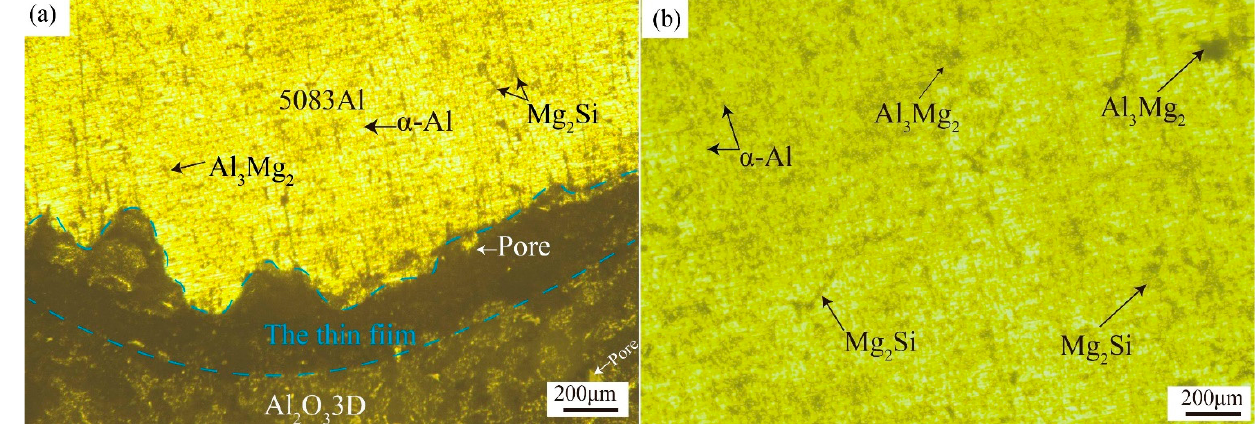
Figure 3. Optical micrograph (OM) image of two materials: ( a ) Al 2 O 3 3D/5083 Al; ( b ) 5083 Al.